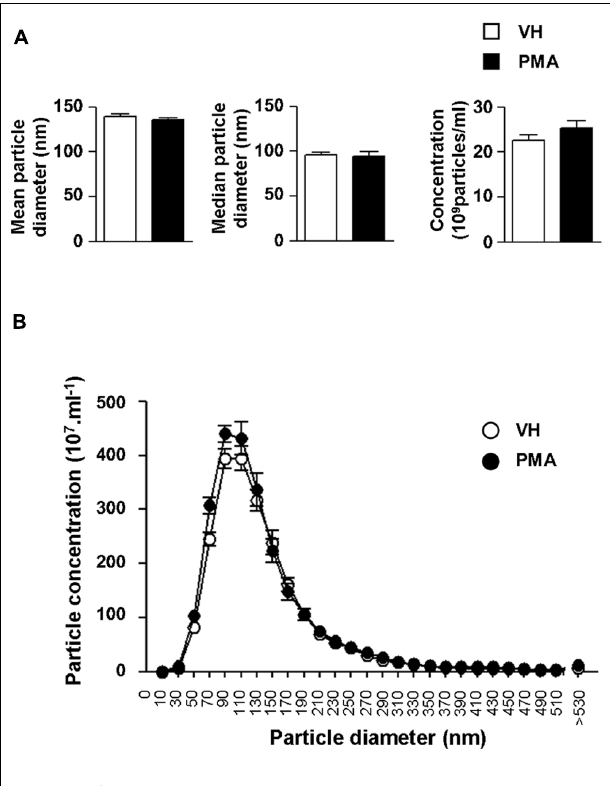
FIGURE 4 | Protein kinase C activation in primary astrocytes does not result in changes in eMV size or concentration. (A) Bar graph showing the quantifications of mean diameter (left panel), median diameter (middle panel) and eMV concentration (right panel) in astrocytes conditioned medium 6 h after vehicle (white bars) or PMA (black bars) exposure. No significant difference could be found (Student’s t -test, n = 5 separate confluent flasks). (B) Size profile of eMV from vehicle (white circles) or PMA (black circles) treated astrocytes ( n = 5 separate confluent flasks for each condition).